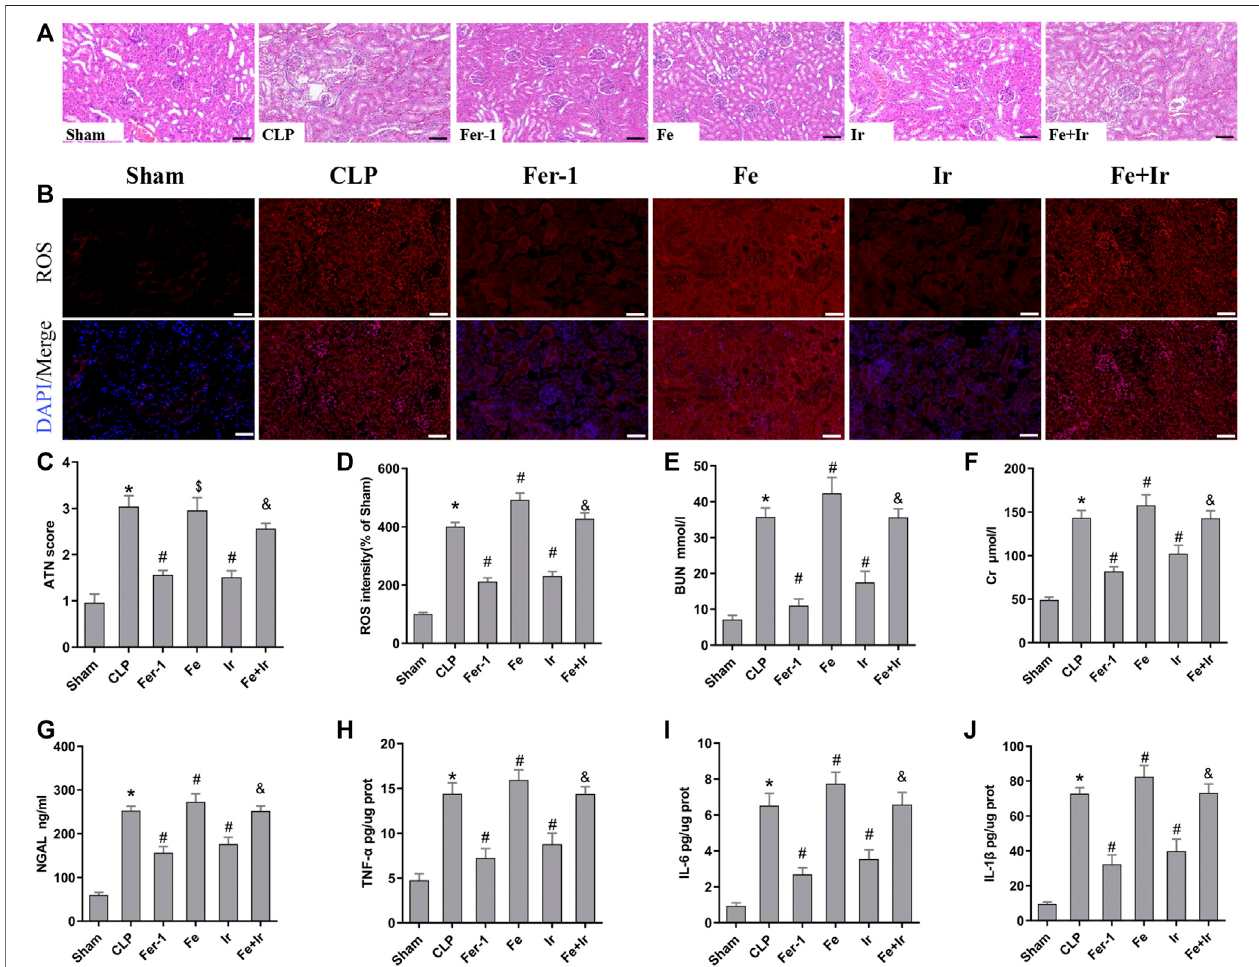
FIGURE1| IrisinattenuatesCLP-inducedkidneyinjury.MiceweregivenashamoperationorCLPmodeloperation,withorwithoutirisin(Ir),ferrostatin-1(Fer-1),or/ and Fe-citrate (Fe) (Fe + Ir) administration. (A) Representative images (200×) showing HE staining of renal sections (scale bar = 50 μ m). (B) Representative fl uorescent images of DHE staining (scale bar = 50 μ m). (C) Acute tubular necrosis score (ATN score). (D) The quanti fi cation of the DHE fl uorescence intensity. (E) BUN concentrationintheplasma. (F) Creatinine(Cr)concentrationintheplasma. (G) Plasmaneutrophilgelatinase-associatedlipocalin(NGAL)concentration. (H – J) The level of TNF- α , IL-6, and IL-1 β in the kidney tissue. * p < 0.05 vs. Sham group, p < 0.05 vs. CLP group, P < 0.05 vs. Fe group, and p > 0.05 vs CLP group. Data are presented as mean ± SD ( n = 10).